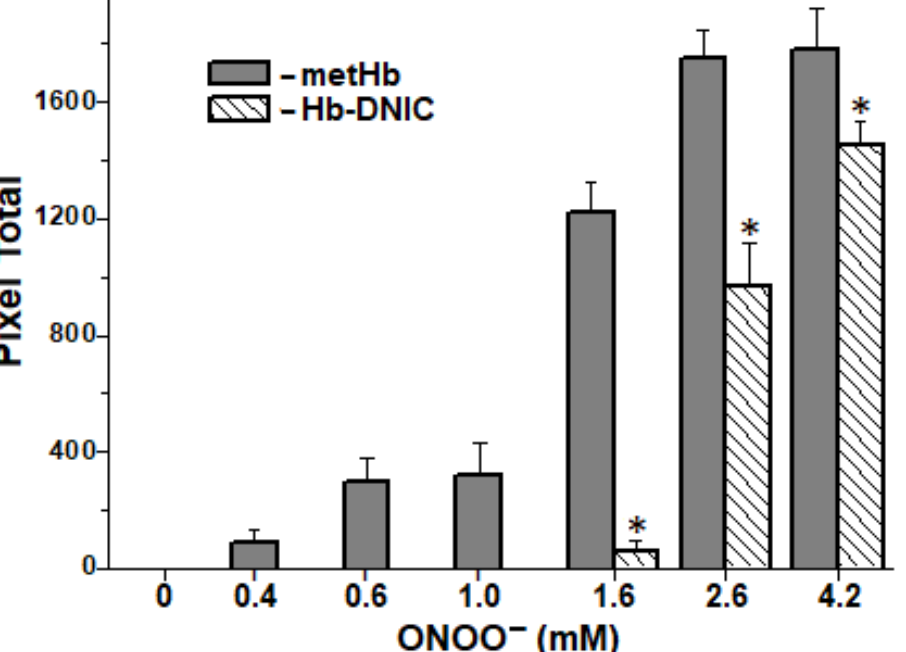
Figure 8. Total amount of covalent aggregates of metHb subunits. According to the data of SDS electrophoresis in 12 % PAAG with dithiothreitol (DTT). *Differences were considered significant at p < 0.05.